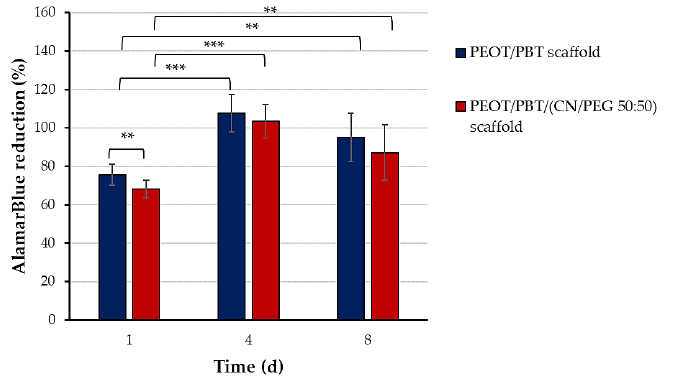
Figure 5. Bar graphs displaying the AlamarBlue ® assay results, indicated as dye reduction percent, of hMSCs differentiated into fibroblasts for 8 days on PEOT/PBT and PEOT/PBT/(CN/PEG 50:50) scaffolds. Data are expressed as mean ± standard deviation ( n = 3; ** p < 0.01; *** p < 0.001).